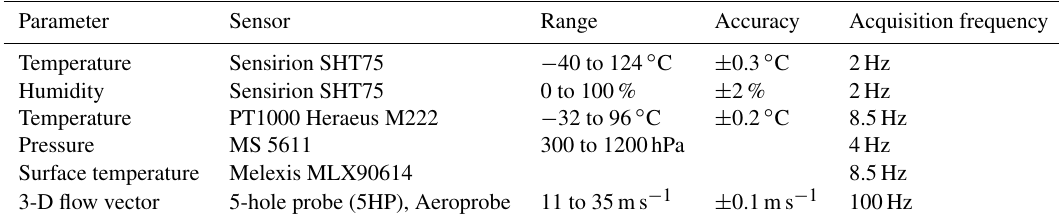
Table 1. Specifications of the meteorological